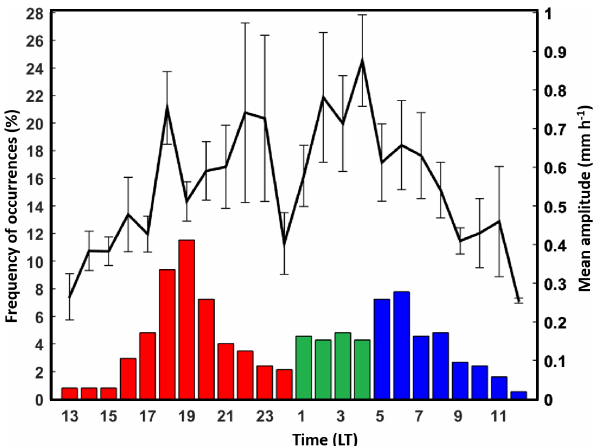
Figure 4. Diurnal distribution of the mean amplitude of the first har- monic components (solid black line) and frequency of occurrence of the peak precipitation time (coloured bar chart) differentiated into three groups (same as in Fig. 3): AEP (red), EMP (green), and LMP √ n ) are plotted as vertical (blue). The sampling errors ( ± σ/